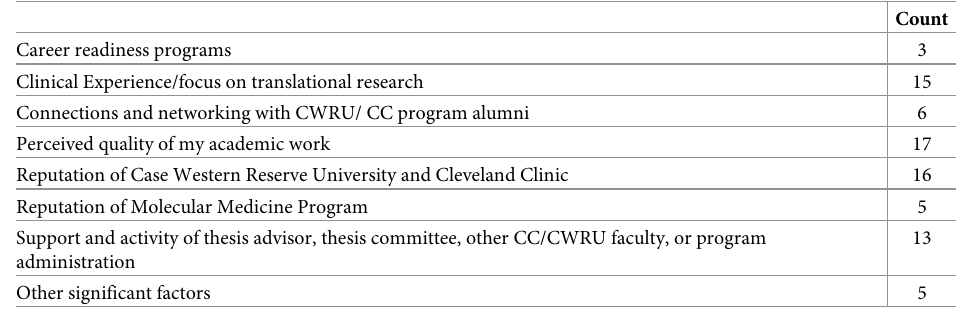
Table 3. Significant